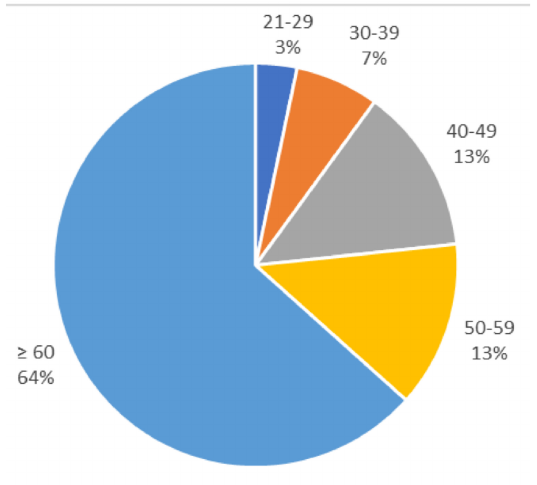
Figure 2. Percentage of patients within each age group.